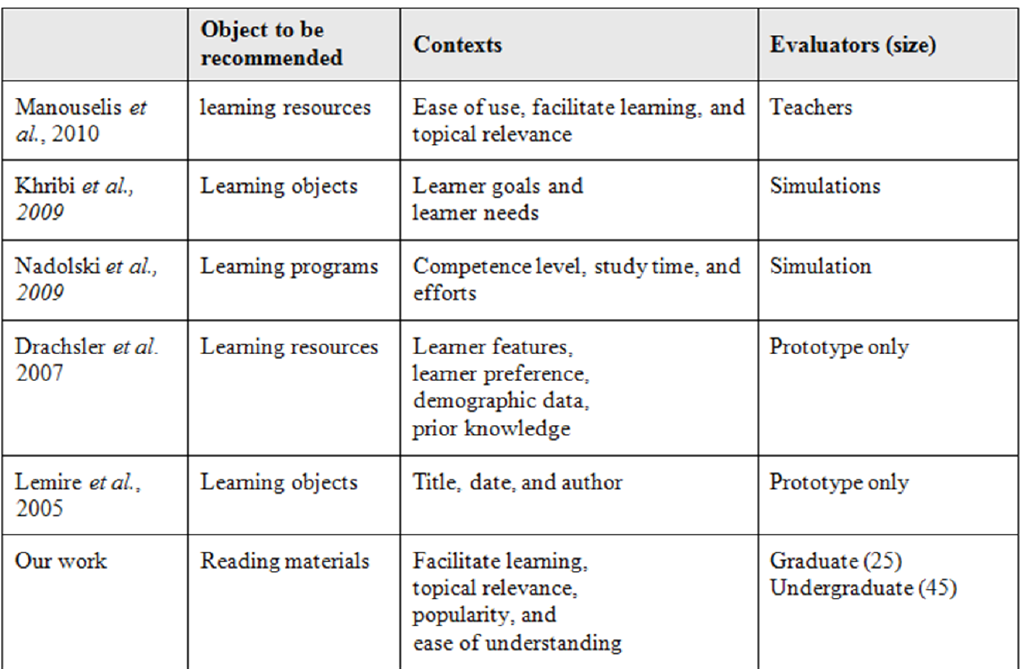
Various Studies in (Context-aware) Education